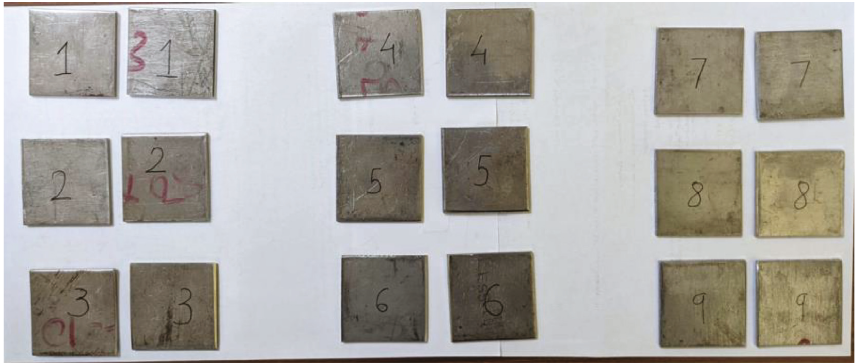
Figure 1: 9 pairs of 310 SS sheet specimen before welding (base metal).